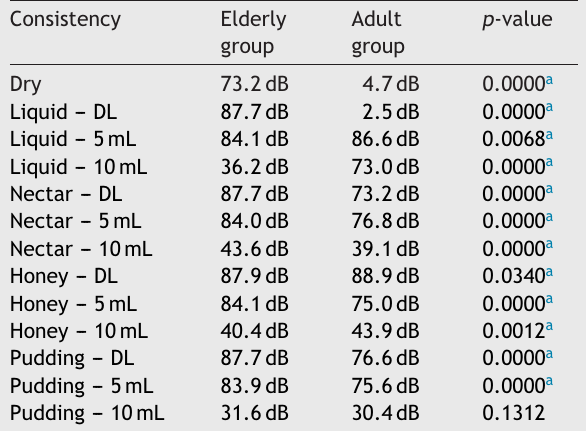
Comparison between the elderly (GI) and adult (GII) groups for final intensity (FI).